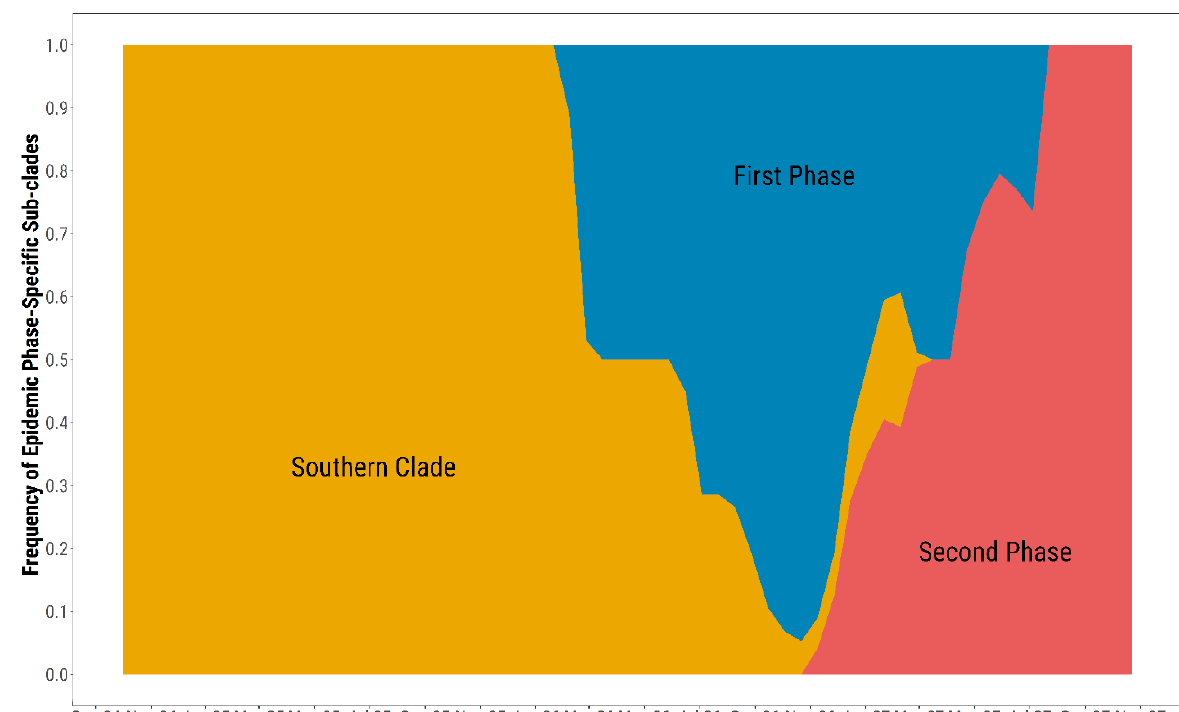
Figure 3. Inferred frequency of epidemic phase specific SVD lineages characterising the 2006–2007 SVD epidemic in northern Italy. The y -axis shows the proportion of SVD sub-clades contributing temporally to the epidemic ancestry makeup, while the x -axis represents the root-to-tip time extent.